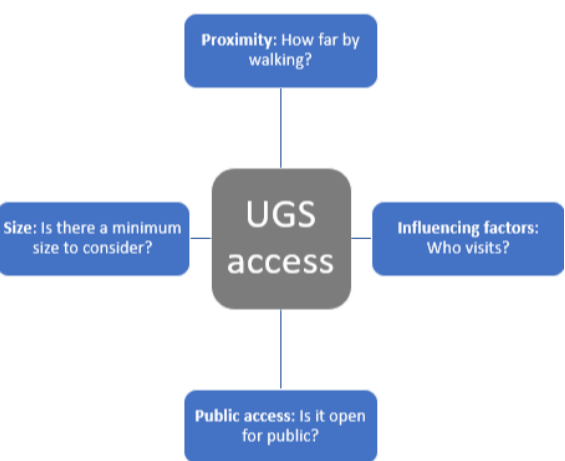
Figure 1. Conceptual and methodological questions in UGS